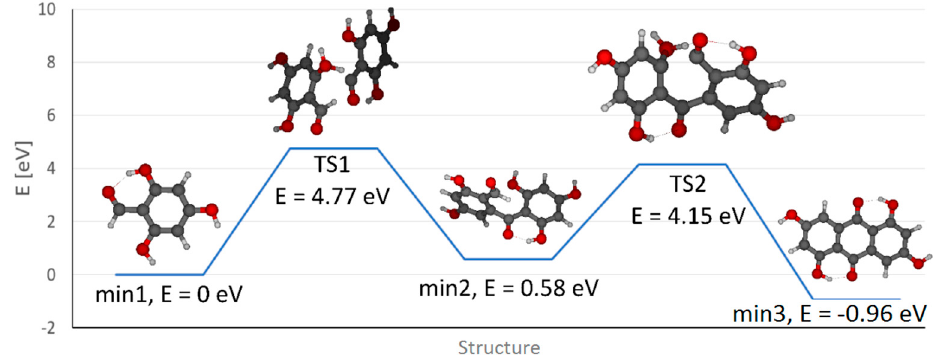
Figure 4. Energy profile of the phloroglucinaldehyde condensation to ATCS. (min—optimized structures with minimum energy; TS—transition states reflecting energetic barriers).